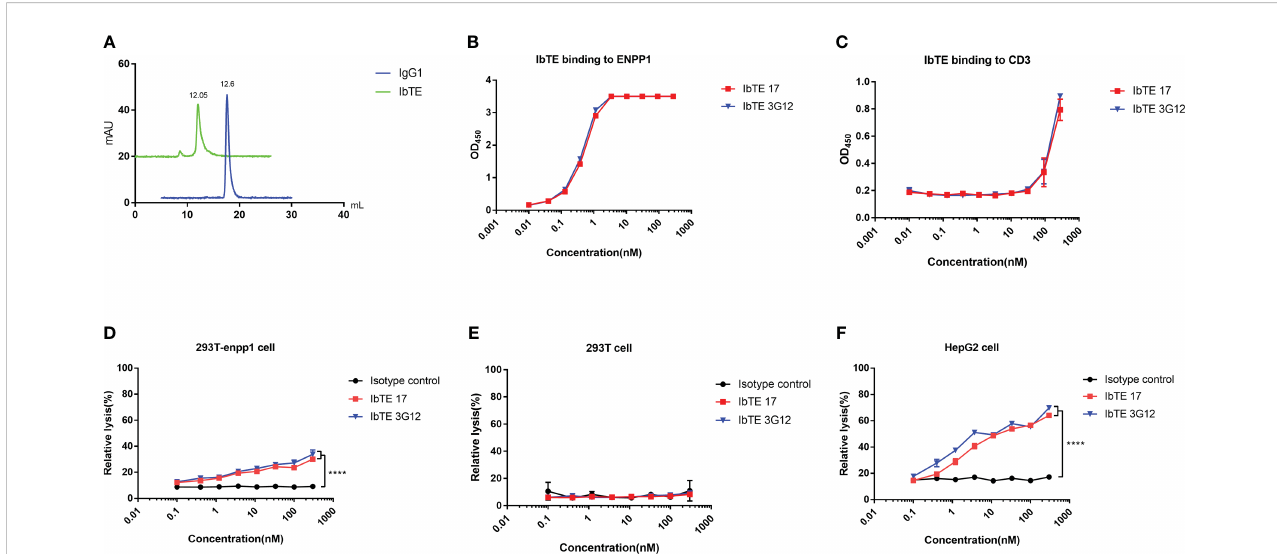
FIGURE 4 In vitro cytotoxic of T cells to ENPP1-expressing cells induced by anti-ENPP1 IbTEs. (A) , Aggregation evaluation of IbTE 3G12 and IgG1 3G12 measured by SEC. (B, C) IbTE 17 and 3G12 binding to ENPP1 (B) and CD3 (C) were measured by ELISA. (D – F) , Percent relative lysis of 293T-ENPP1 cells by T cells (D) , 293T cells (E) , and HepG2 cells (F) mediated by IbTE 17 and 3G12, respectively. T cells and target cells were added to the 96-well plate at an E:T ratio of 10:1 and simultaneously treated with serially diluted IbTE antibodies for 24h. An irrelevant IbTE isotype control was used. The luminescence signal was detected and used to calculate the percent relative lysis. Experiments were performed in duplicate. Values were reported as the mean of percent relative lysis ± SD. The experiment was repeated three times. Signi fi cance was tested by using two-way ANOVA, followed by Tukey ’ s multiple comparisons test. ****, p